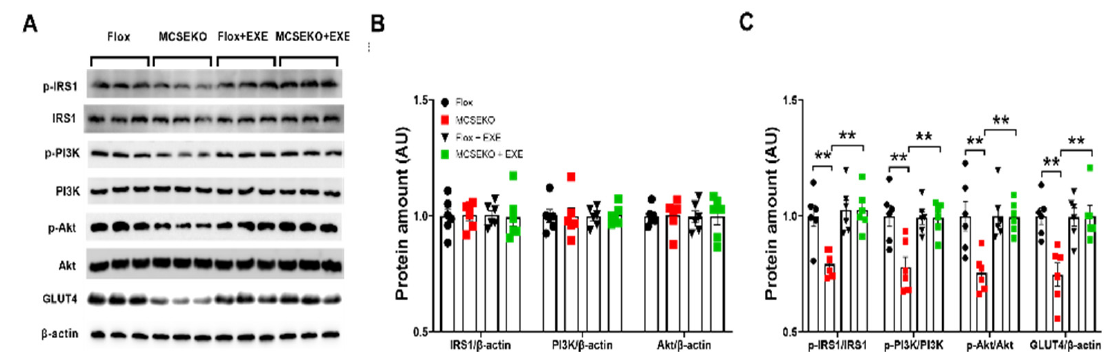
Figure 8. Aerobic treadmill exercise increases GLUT4 levels and IRSI/PI3K/Akt signaling in MCSEKO mice. MCSEKO mice and Flox mice were housed under standard conditions. Aerobic treadmill exercise was performed on the mice at 14 weeks old for six weeks. Western blot analysis of p-IRS1, IRS1, p-PI3K, PI3K, p-Akt, Akt, and GLUT4 levels in GAS. ( A ) The representative images of western blotting. ( B , C ) Cumulative data of western blotting images. Data were expressed as means ± SEM ( n = 6 in each group). ** p < 0.01. EXE: exercise.